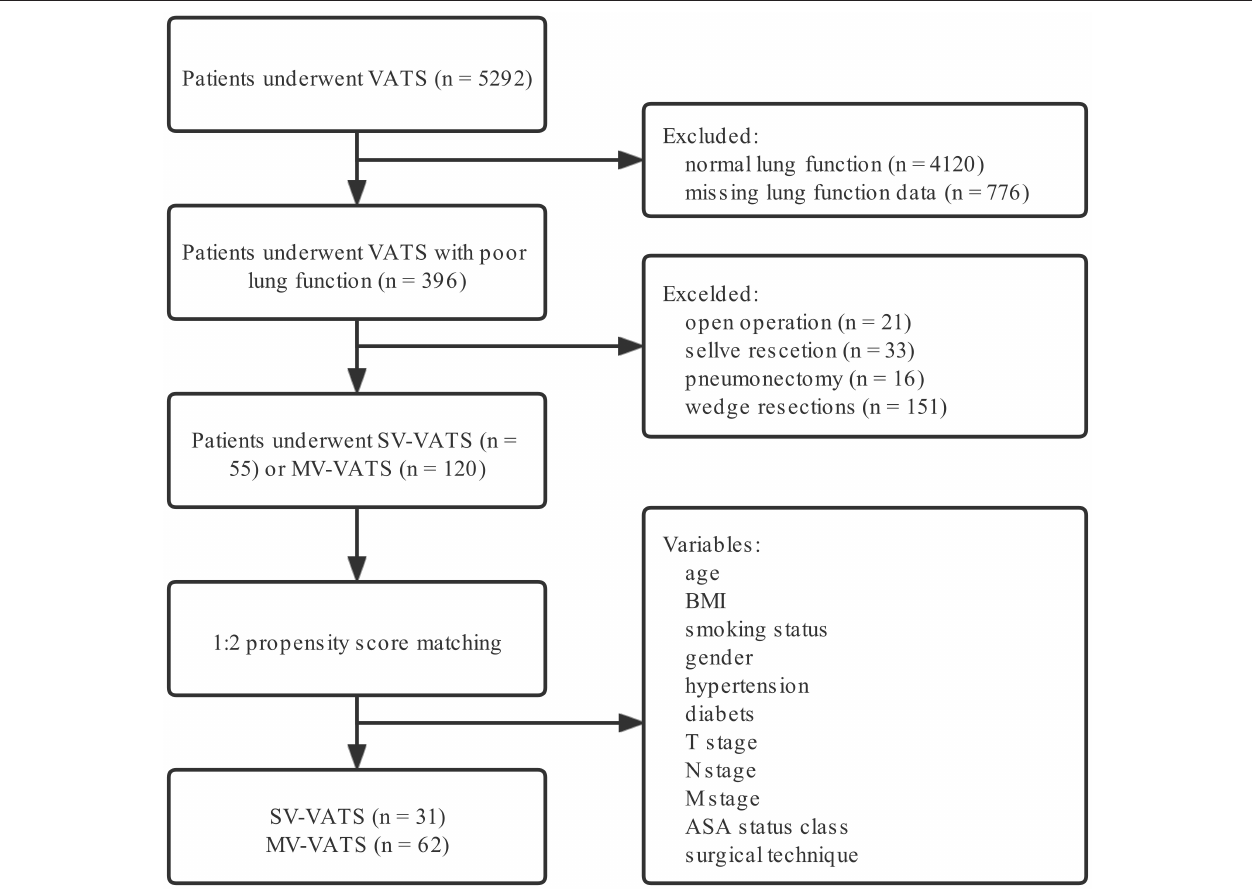
FIGURE 1 | Flow chart of patient inclusion. NSCLC, non-small-cell lung cancer; SV-VATS, spontaneous ventilation video-assisted thoracoscopic surgery; MV-VATS, mechanical ventilation; BMI, body mass index; T, tumor; N, node; M, metastasis; ASA, american society of anesthesiologists.